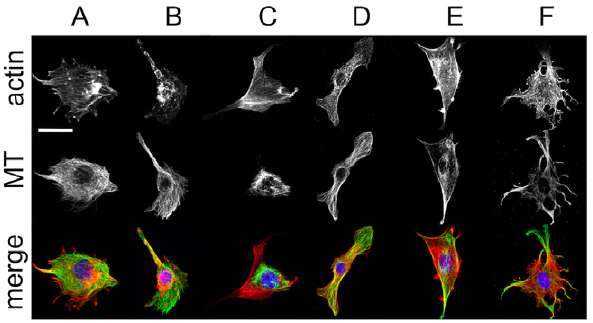
Figure 1. Fixed and stained images of the C2C12 myoblast cytoskeleton. Control cells are show in ( A ) and cells treated with anti- cytoskeletal inhibitors for 60 min are shown in ( B ) Cyt-D, ( C ) nocodazole, ( D ) ML-7, ( E ) Y-27632 and ( F ) blebbistatin. The actin and MT cytoskeleton are shown at the top and middle row respectively. A merged image of the actin (red), MT (green) and nucleus (blue) are in the bottom row. Scale bar=20 m m and applies to all images.